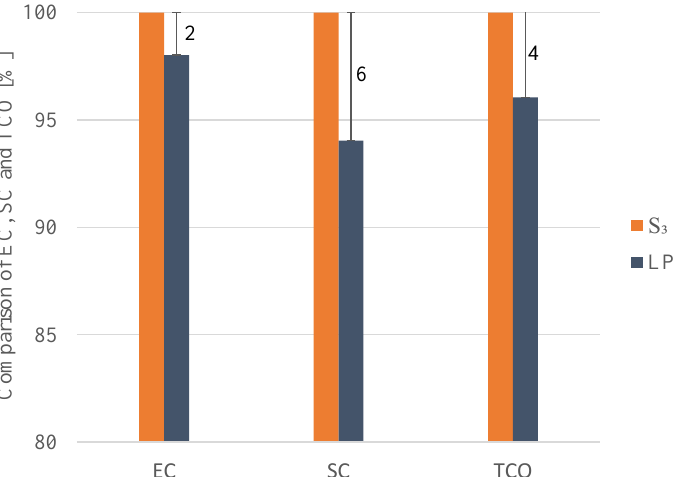
Figure 18. Comparison of normalized EC, SC and TCO between LP (with a total vehicle mass of 1635 kg) and S 3 , where EC represents the energy consumption and SC the system